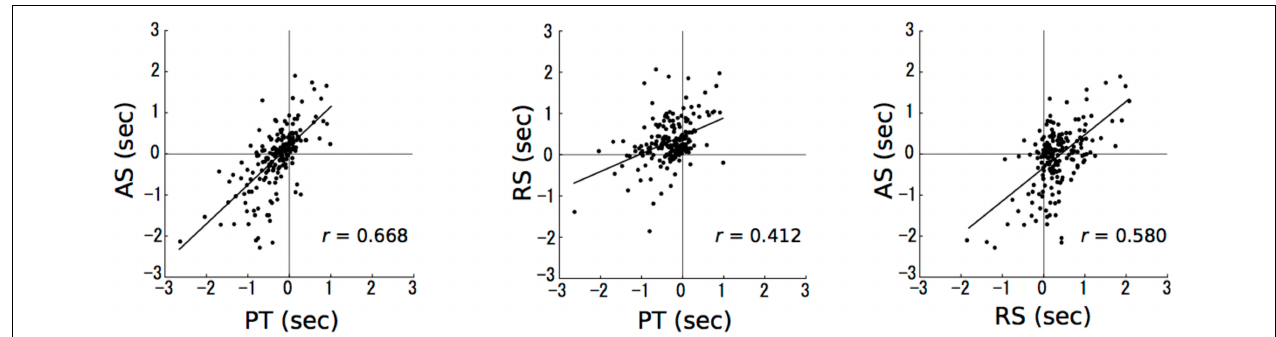
FIGURE 3 | The results of correlation analyses. The numbers in axes represent the differences in time intervals between a stimulus presentation and a reproduction (reproduction – stimulus presentation). The horizontal and vertical axes represent paired tone and accelerando series sessions, respectively (left); paired tone and rhythm series sessions, respectively (middle); and rhythm series and accelerando series sessions, respectively (right). Each data point represents a single participant at a single test duration, so that there are 192 points in each plot [24 (participants) × 8 (durations)].